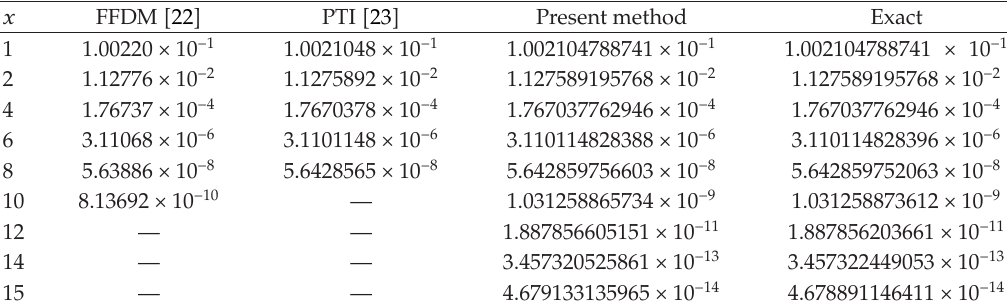
Table 2: Approximate and exact values of y (cid:4) x (cid:3) for Example